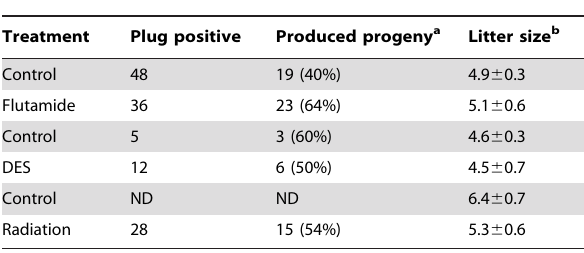
Table 1. Breeding efficiency in 129.MOLF-L1 congenic mice with or without in utero flutamide, DES, or radiation